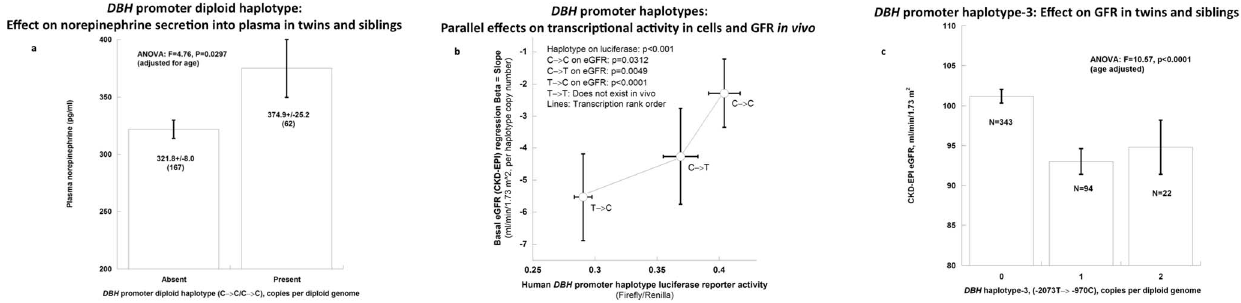
Figure 4. DBH promoter haplotype with adrenergic or GFR traits in twins and siblings. a. DBH promoter diploid haplotype-1 (C R C) association with norepinephrine secretion . b. DBH promoter haplotypes : Inverse association between transcriptional activity (transfected promoter/reporter plasmids in PC12 chromaffin cells) and eGFR. Each promoter transfection was done in 8 replicates. Haplotype numbers for this population were: C R C (n=226; 29.4%), C R T (n=134; %), T R C (n=98; 21.4%), and T R T (n=0). c. DBH promoter haplotype-3 (T R C) : Significant association (P , 0.0001) with eGFR in an age-adjusted model.